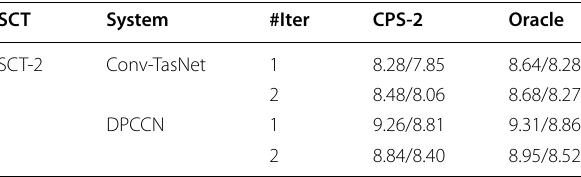
Table 7 Overall SDRi/SI-SNRi(dB) performance with different